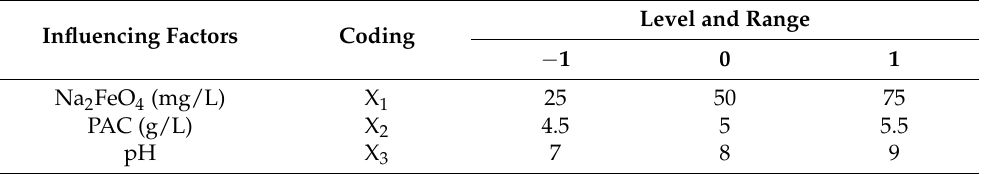
Table 1. Response surface experiment factor level and